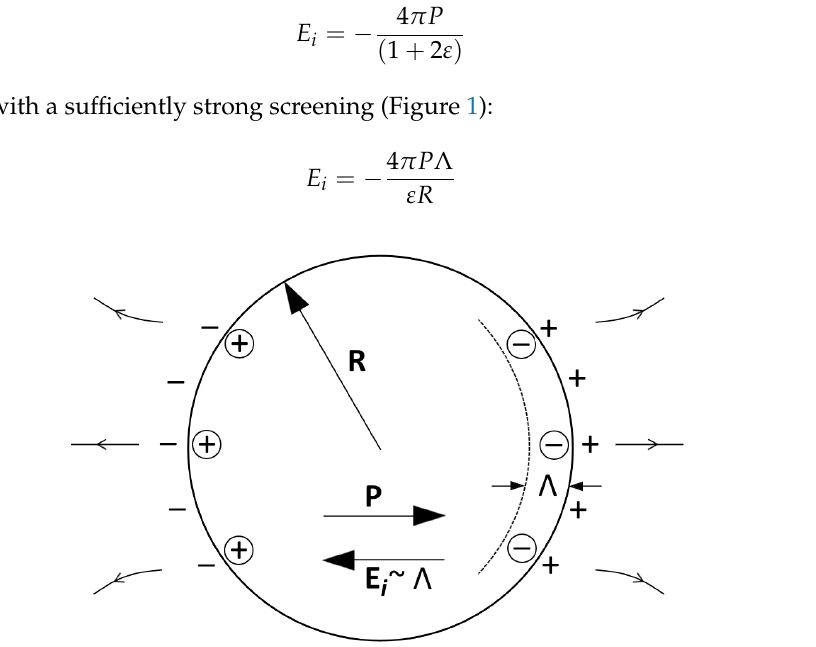
Figure 1. The field inside a sufficiently strongly screened ferroelectric inclusion: R is the inclusion radius; P is the spontaneous polarization of the inclusion; E i is the electric field strength inside the ferroelectric inclusion; Λ is the screening length.